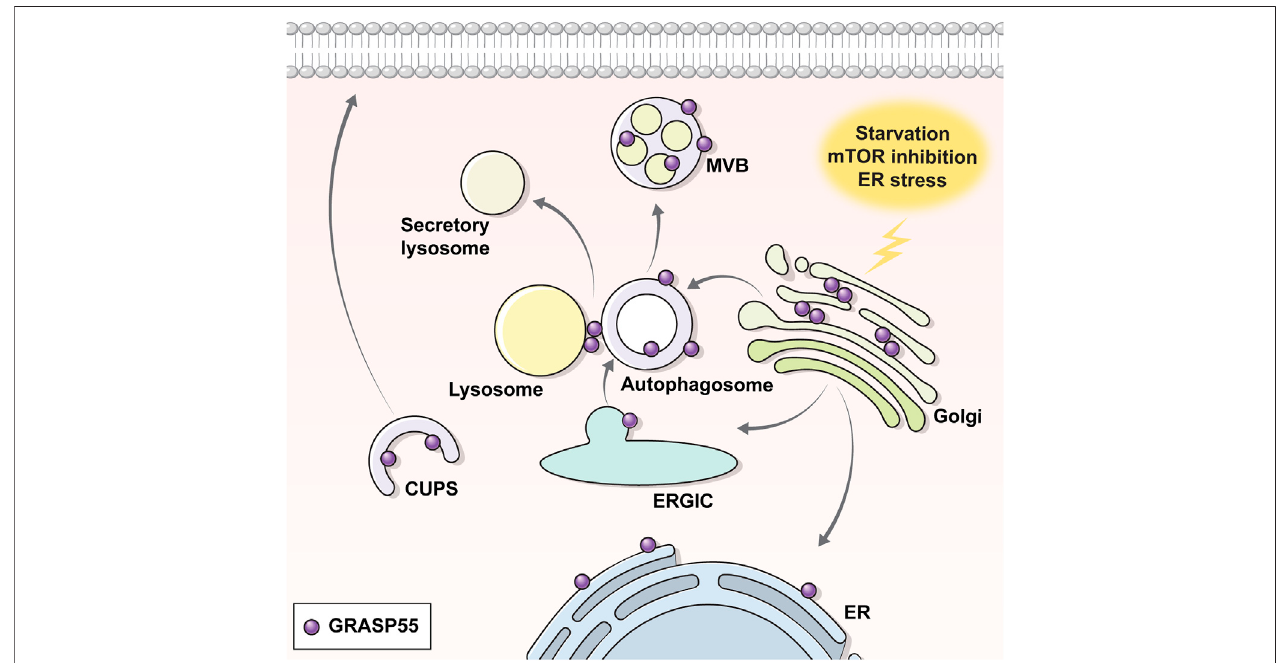
FIGURE 2 | Translocation of GRASP55 upon UPS. Under normal conditions, the Golgi peripheral protein GRASP55 resides at the Golgi. Under UPS-inducing conditions (e.g., starvation, ER stress, ER-to-Golgi block etc.), GRASP55 delocalizes to the ER, autophagosome, multivesicular body or CUPS. Transmission electron microscopic images show that GRASP55 is localized at autophagosomes and multivesicular bodies under ER stress, mTOR inhibition, and starvation conditions (see text for details).